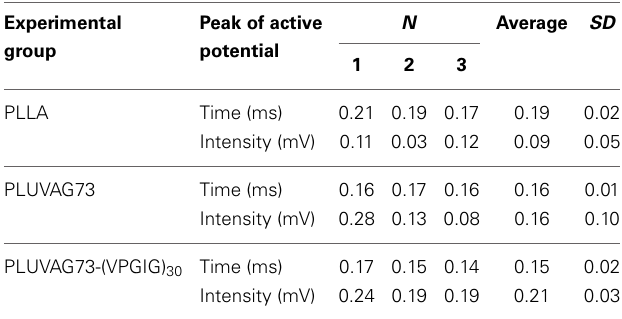
( Figure 6 ). The action potential of healthy tibial nerve was 0.9 mV at 0.12 ms. The intensity and peak time of the action